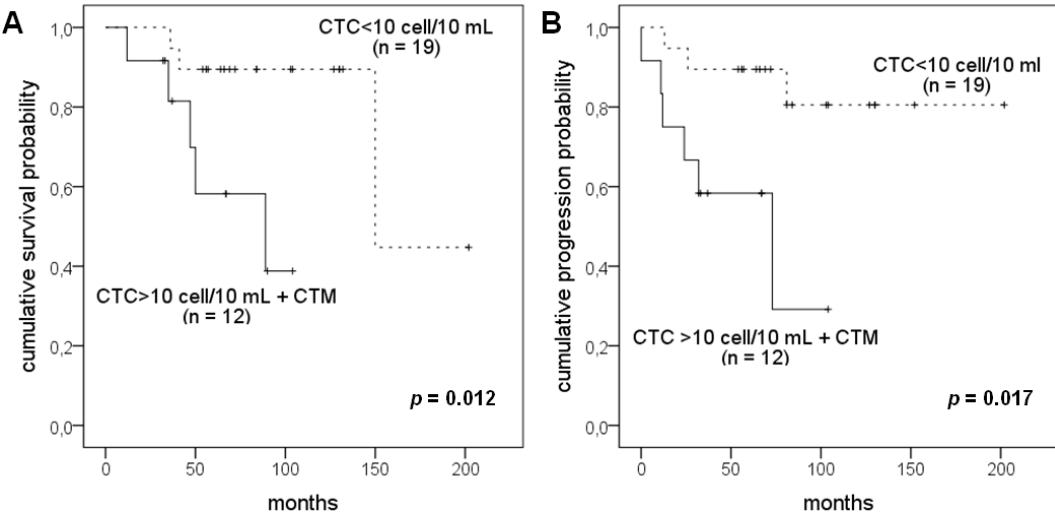
Figure 4. Kaplan-Meier curves for disease free ( A ) and overall survival ( B ) in the whole case